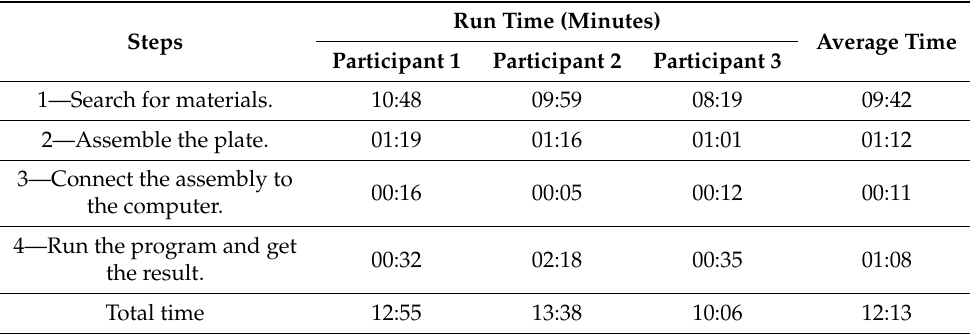
Table 2. Initial experimental procedure run